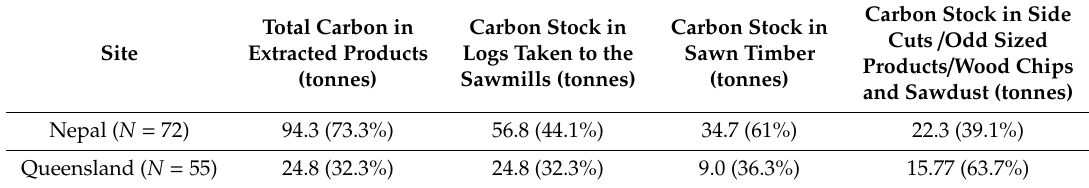
Table 6. Flow of carbon in processing stage at sawmill in Nepal and Queensland